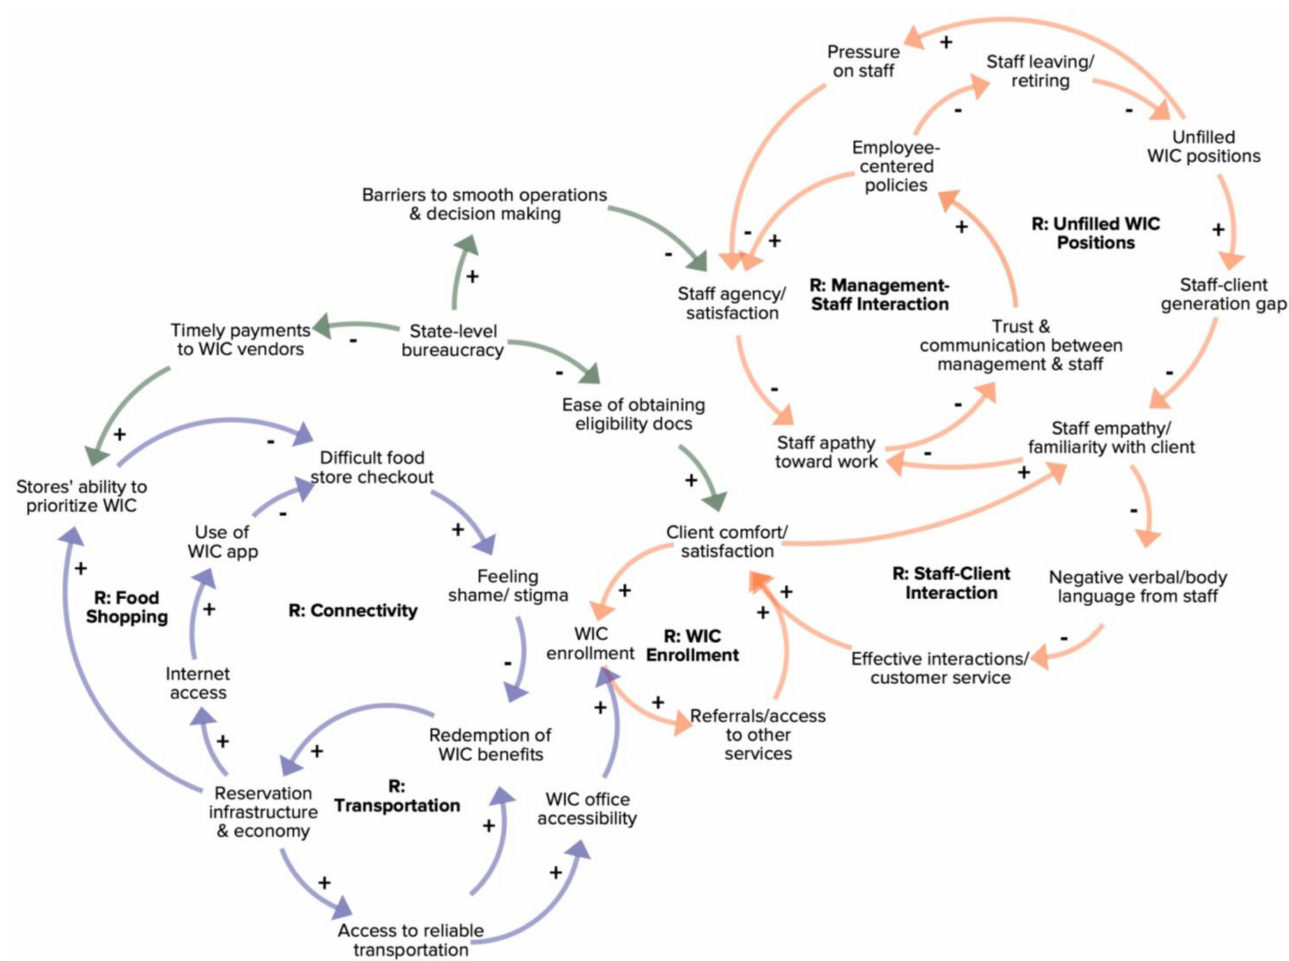
Figure 1. Causal loop diagram of factors influencing participation the Navajo Nation WIC